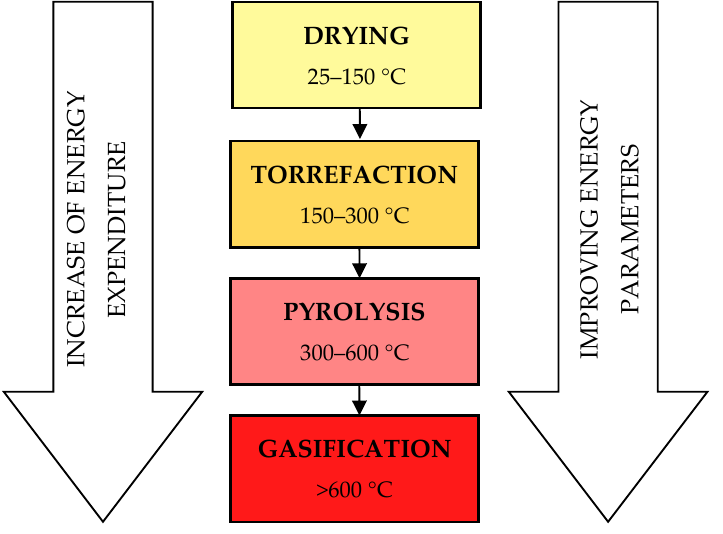
Figure 2. Biomass thermal treatment — processes and range of temperatures.